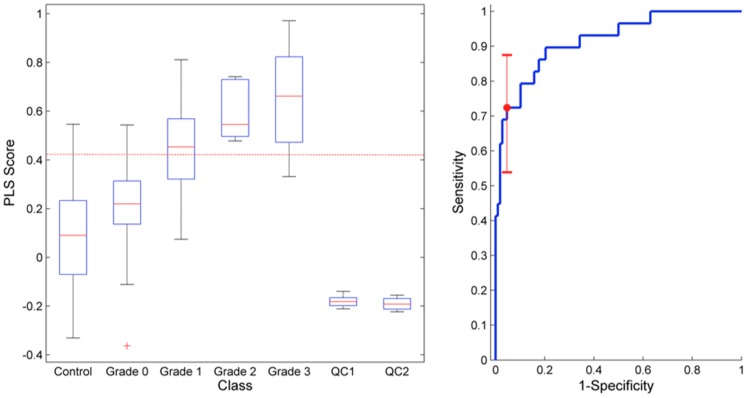
The predictive scores for a PLS-DA model built to discriminate between HIE versus all other outcomes (asphyxia and both the control groups) using the complete data set.The PLS score box plot is grouped by Sarnat score. Here a Sarnat score of zero is equivalent to the “asphyxia” classification, and Sarnat grade of 1, 2 and 3 represent the 3 levels of increasing HIE severity. The model was optimally built using 2 latent factors. The model had an R2 = 0.32, Q2 = 0.22, and an AUC of 0.92 (95% CI: 0.84–0.97). For a fixed specificity of 0.95 the corresponding sensitivity for predicting HIE (at any level) is 0.75 (95% CI: 0.55–0.88), the corresponding decision boundary is indicated by a dashed line in the boxplot. Note: the Quality Control samples (repeated injection of serum from two control patients: QC1 & QC2) are projected through the PLS-DA model and the subsequent predictions give an estimation of model precision.